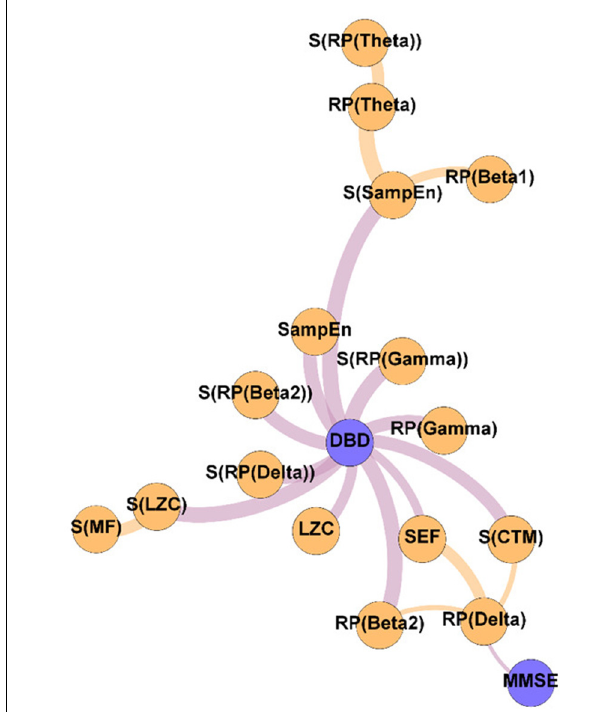
FIGURE 4 | Variability network, showing the 5% strongest connections corresponding to the network edges that obtained the most significant differences between Pre-NPT and Post-NPT networks. Wider edges correspond with stronger associations. Nodes corresponding to cognitive and behavioral parameters are shown in blue, while nodes of neurophysiological parameters are shown in orange.